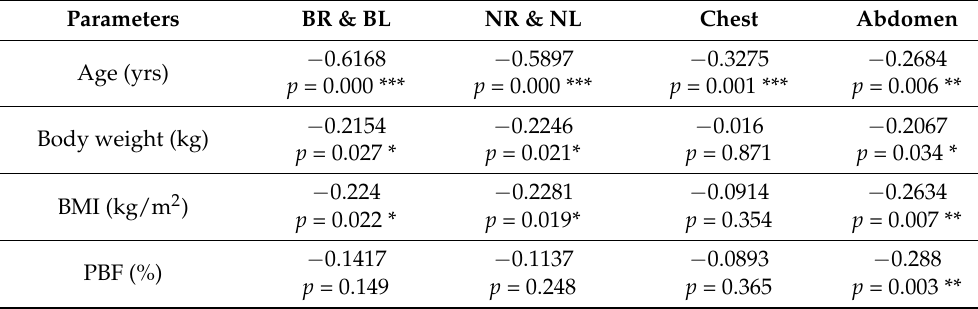
Table 4. The results of the correlation of chronological age, body weight, BMI index, and PBF vs. T mean ( ◦ C) of selected body